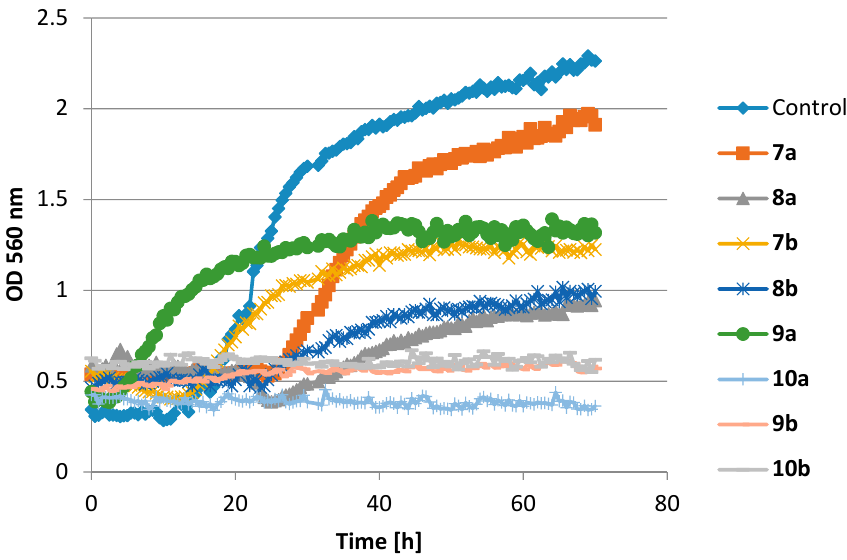
Figure 3. The effect of action of O -alkyl derivatives of naringenin ( 7a – 10a ) and their oximes ( 7b – 10b ) on the growth of F. linii KB-F1.